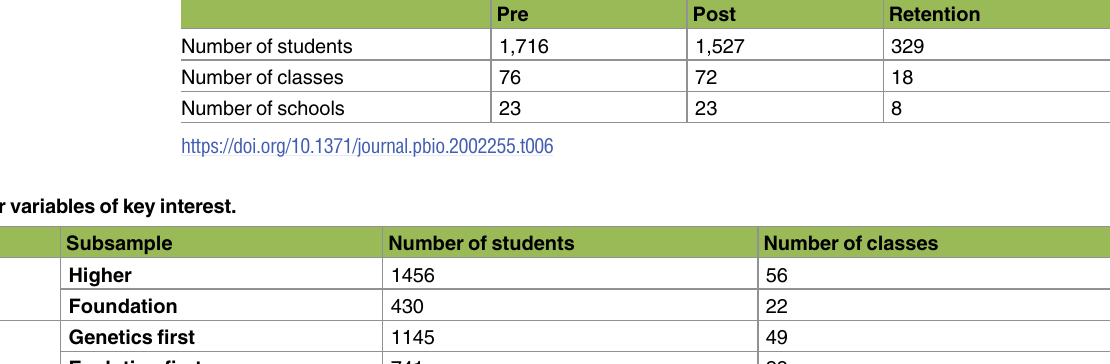
Table 6. Overview of student questionnaire data collected.